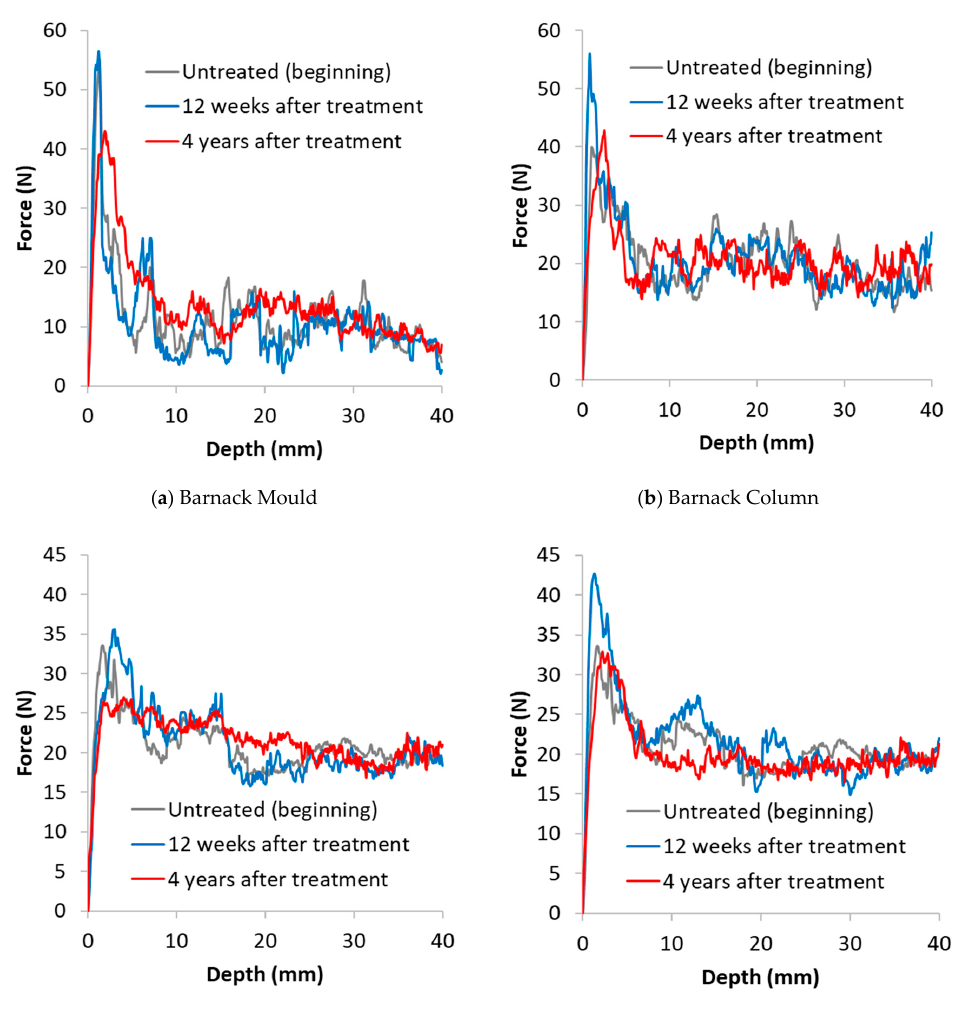
Figure 6. Drilling resistance vs. drilling depth untreated (beginning), 12 weeks after treatment and 4 years after treatment of stone specimens for which nanolime had a neutral consolidating effect. ( a ) Barnack Mould; ( b ) Barnack Column; ( c ) Magnesian Limestone “Inside”; ( d ) Magnesian Limestone “Outside”.